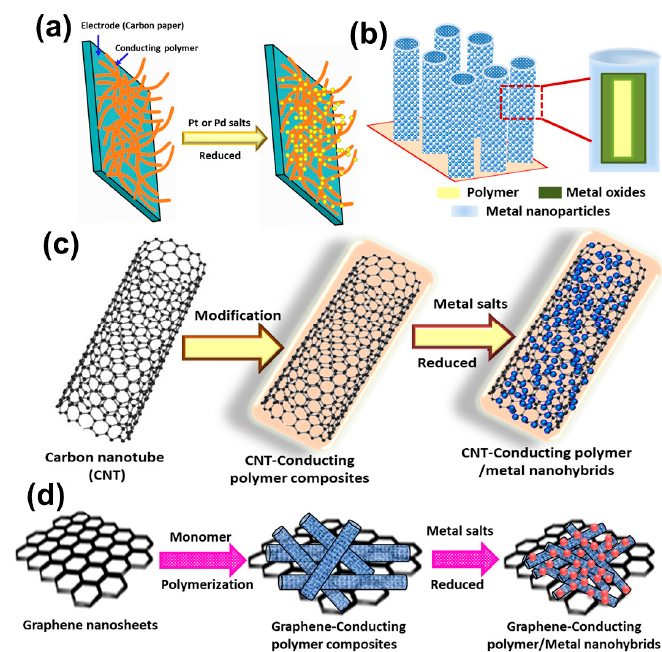
Figure 4. Schematic representations of polymer-modified support-based nanohybrid electrodes: ( a ) carbon electrode–polymer/metal, ( b ) metal oxides–polymer/metal, ( c ) carbon nanotubes–polymer/metal, and ( d ) graphene–polymer/metal.